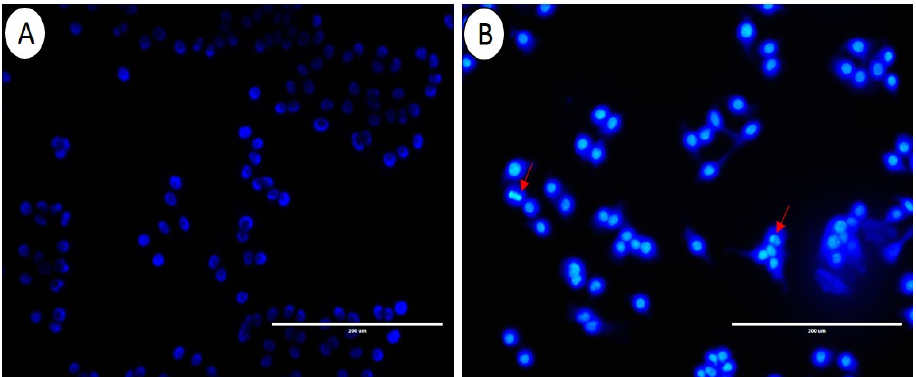
Figure 11. DAPI (4 ′ ,6-diamidino-2-phenylindole) pictures of MCF7 cells. Control cells ( A ), Cells treated with Asf-AgNPs. ( B ). Red arrows designate apoptotic cells.